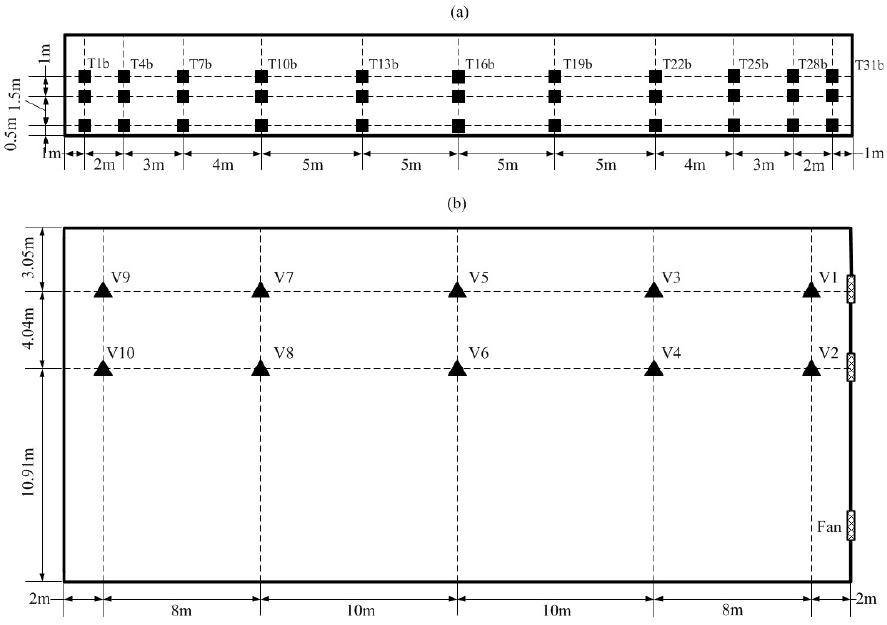
Figure 6. Locations of temperature and air speed sensors: ( a ) the side view of temperature sensor matrix, ( b ) the top view of the air velocity sensor matrix.